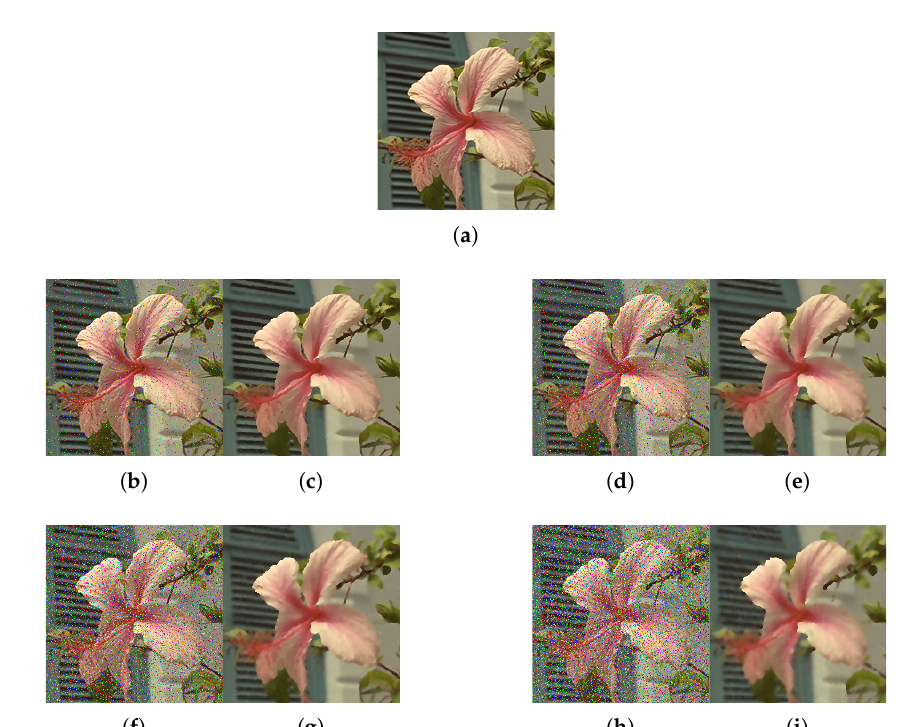
Figure 13. Method outputs using test image Flower contaminated with various intensities of impulsive noise p . ( a ) Flower. ( b ) Noisy p = 0.05. ( c ) Filter output. ( d ) Noisy p = 0.1. ( e ) Filter output. ( f ) Noisy p = 0.2. ( g ) Filter output. ( h ) Noisy p = 0.3. ( i ) Filter output.